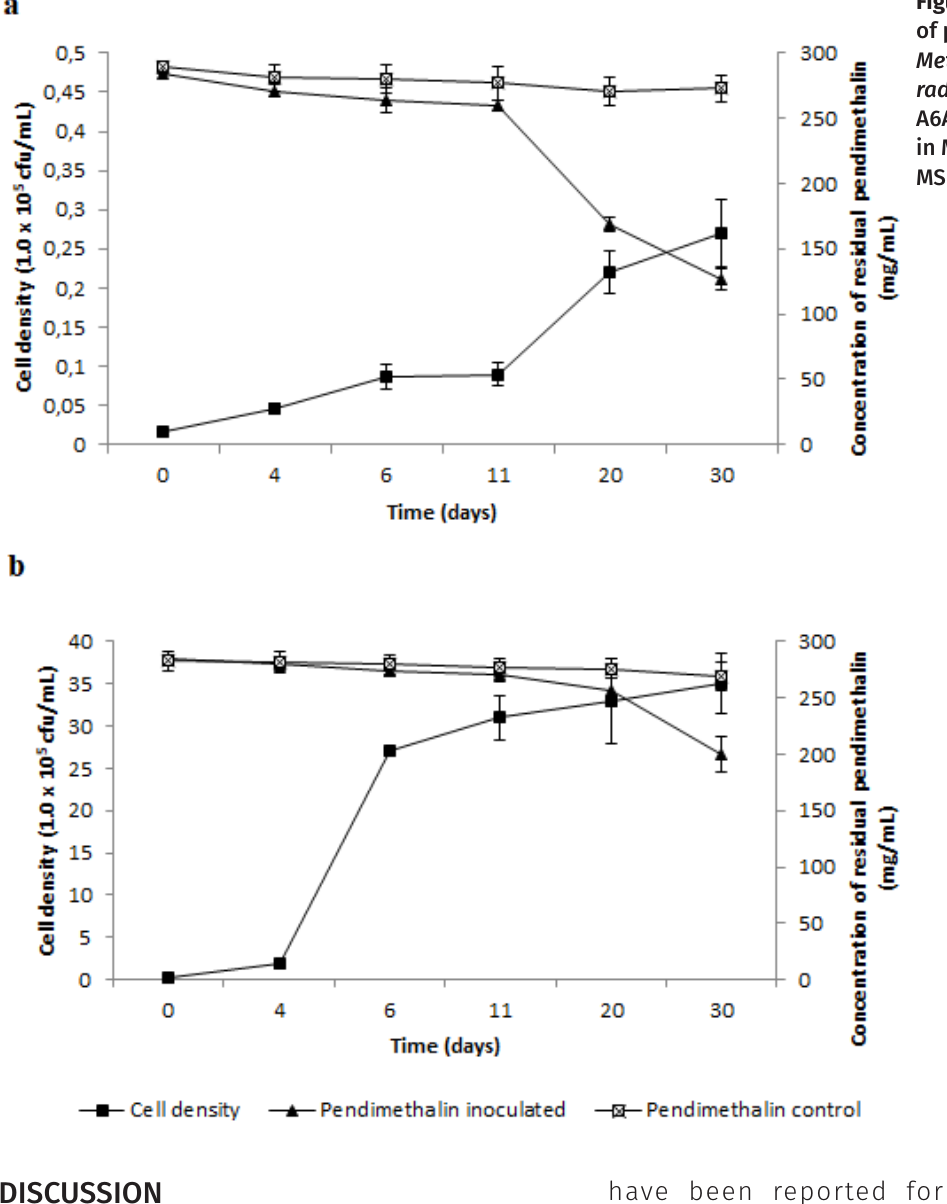
Figure 3. Biodegradation of pendimethalin by Methylobacterium radiotolerans A6A1PR46-4 strain in MSPEN (a) and MSPENGLI (b)